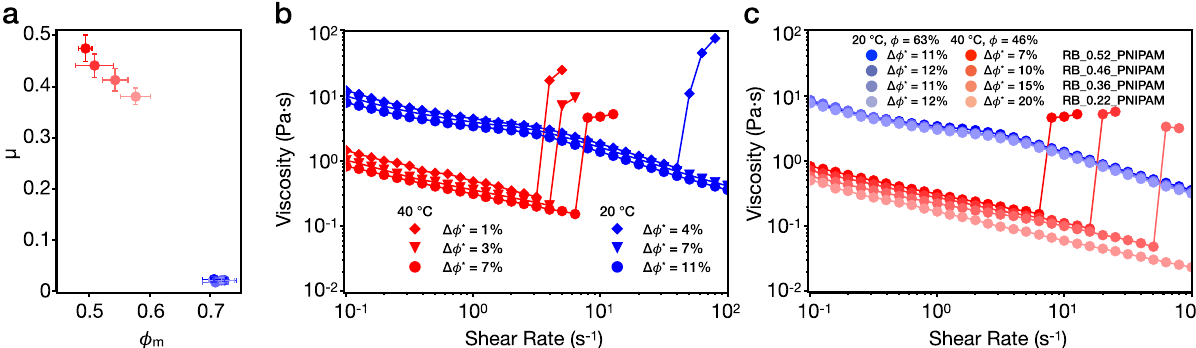
Fig. 5 Rheology experiments on PNIPAM-grafted rough particles. a μ as a function of ϕ m of the four PNIPAM-grafted rough systems (same legends as Fig. 4c) at 20 °C (blue) and 40 °C (red). μ at 20 °C was calculated from 10 to 30 nN applied load. Error bars in μ and ϕ m represent the uncertainties in the calculated slope based on Eq. (1) and the standard deviations from four repeat measurements, respectively. b Rheological fl ow curves of RB_0.52_PNIPAM in various values of ϕ at 20 °C (blue) and 40 °C (red). c Rheological fl ow curves of the four PNIPAM-grafted rough systems with ϕ = 63% at 20 °C (blue) and ϕ = 46% at 40 °C